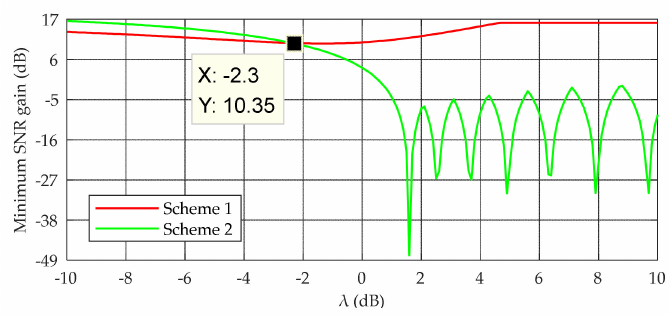
Figure 6. Minimum SNR gain as a function of λ